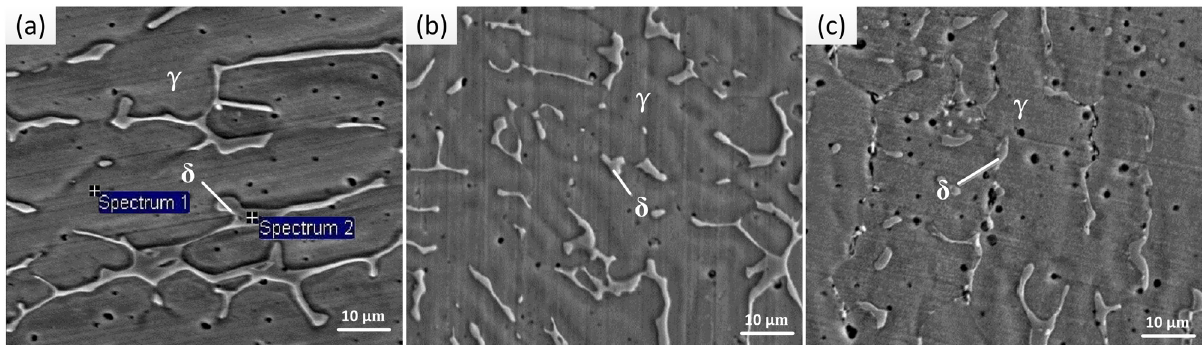
Figure 7: SEM morphology of weld before and after heat treatment: ( a ) AW joint, ( b ) after annealing treatment at 400°C for 4 h, and ( c ) after ST at 1,050°C for 30